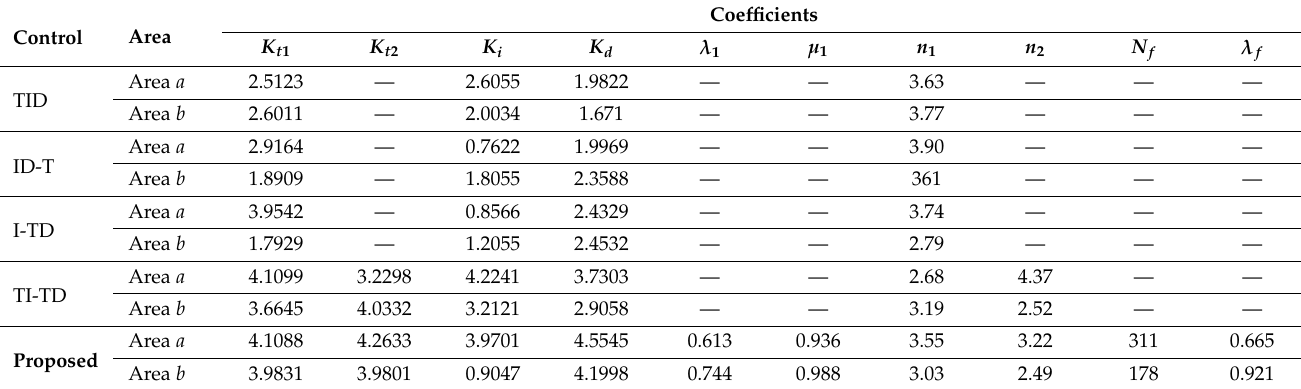
Figure 19. The dynamic response of the system to scenario 5. Table 11. The obtained optimal controllers parameters with RESs